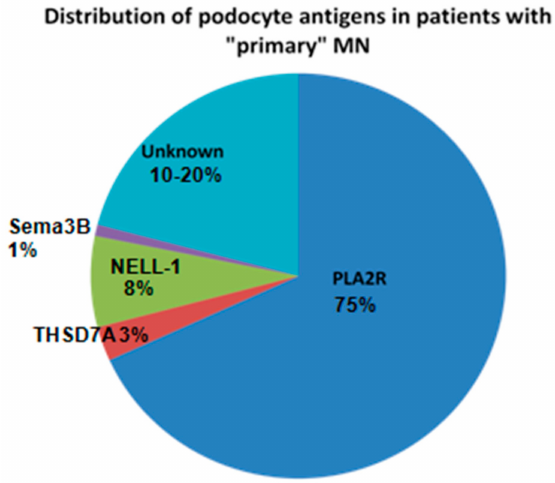
Figure 3. Distribution of podocyte antigens in patients with “primary” membranous nephropa- thy